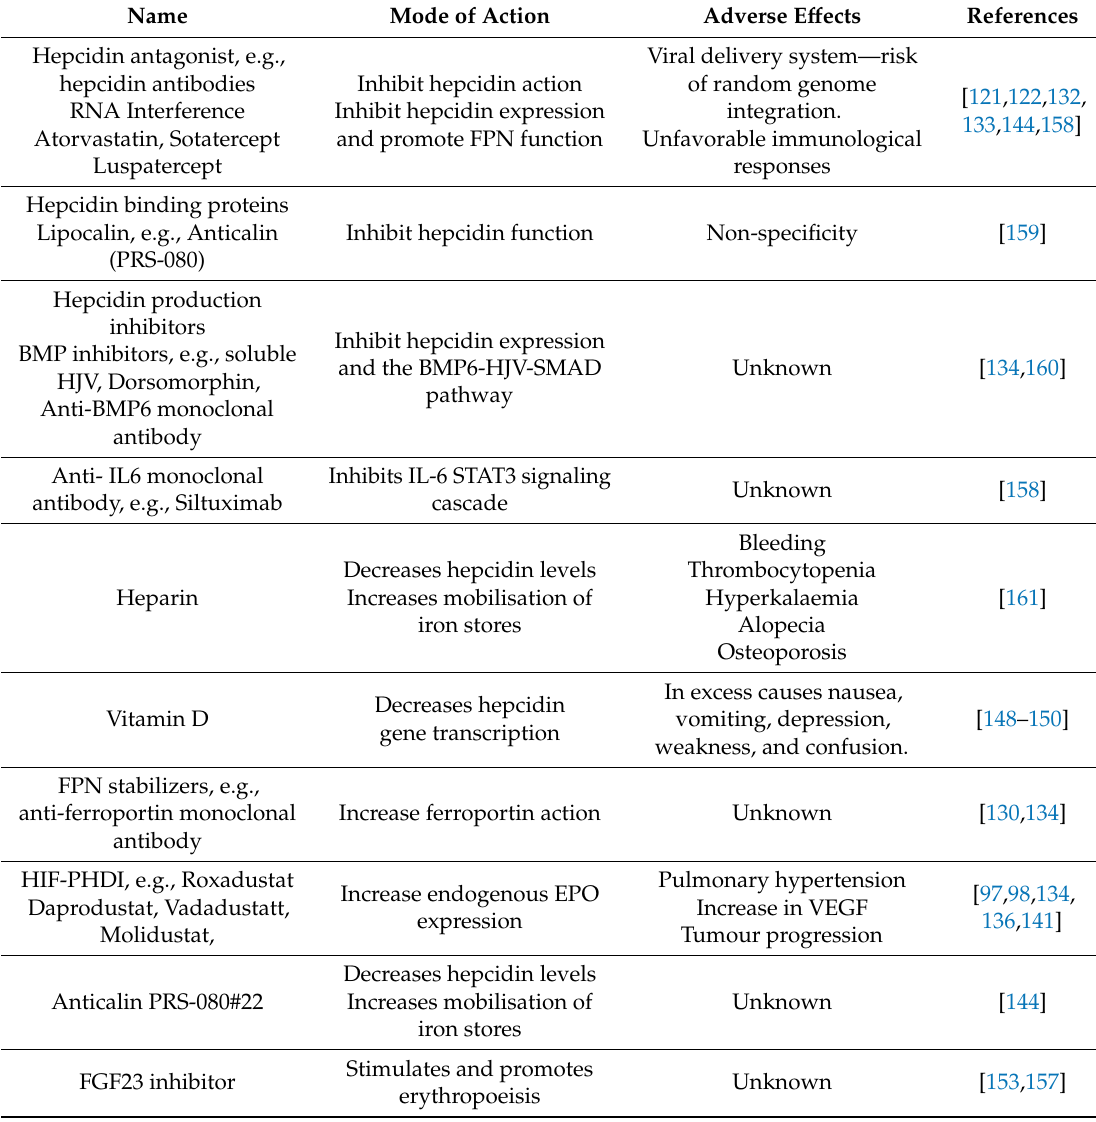
Table 2. Summary of potential therapies for anemia of chronic kidney disease